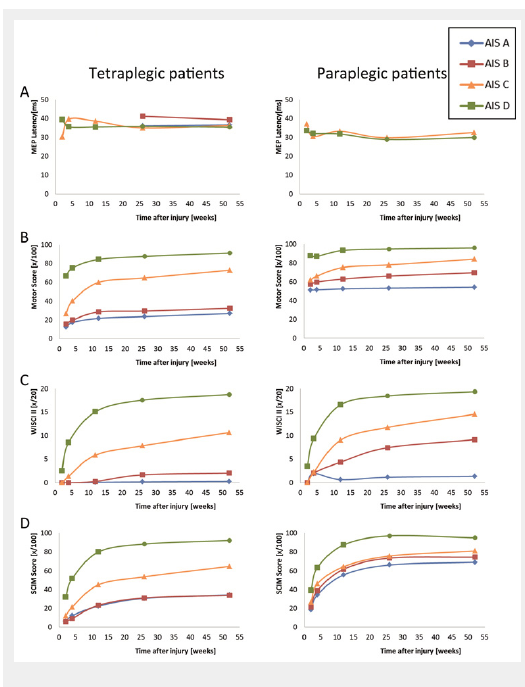
Improvement in motor functions and activities. Patterns of improvement in various motor functions and activities are shown for patient groups, which are categorised according to the level of lesion (tetraplegic versus paraplegic patients) and ASIA Impairment Scale (AIS). Patterns are shown of (A) the latency of motor evoked potentials (MEPs) evoked by transcranial magnetic stimulation, (B) the motor score of the key muscles according to the International Standards, (C) improvements in walking aids, braces and personal assistance as quantified with the revised Walking Index for Spinal Cord Injury (WISCI II) and (D) activities of daily living and independence as scored with the Spinal Cord Independence Measure (SCIM). (Numbers are based on